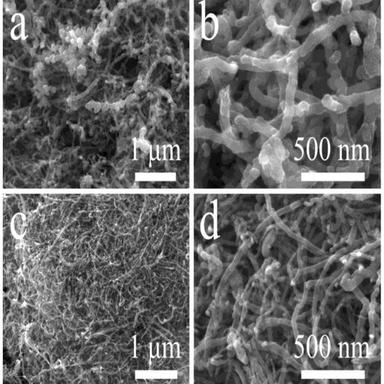
SEM images of CNT@MnO@NC (a, b) and OCNT@MnCO3 (c, d) hybrids.